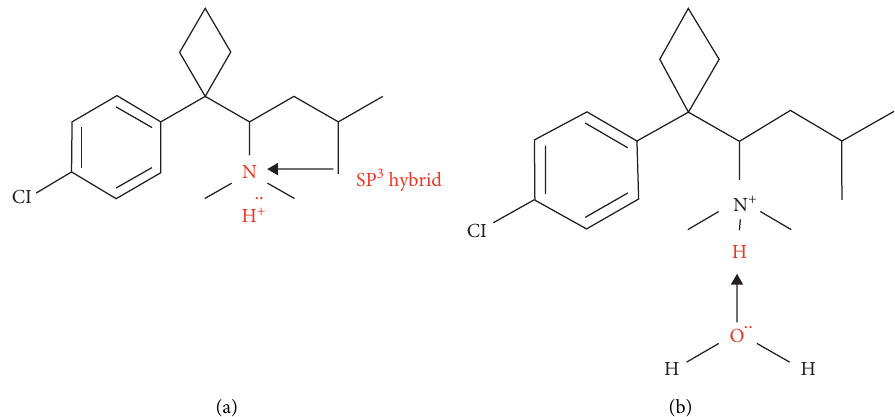
Figure 1: Schematic of dissolution in acid aqueous solution of sibutramine. (a) Protonation of sibutramine. (b) Solvation of